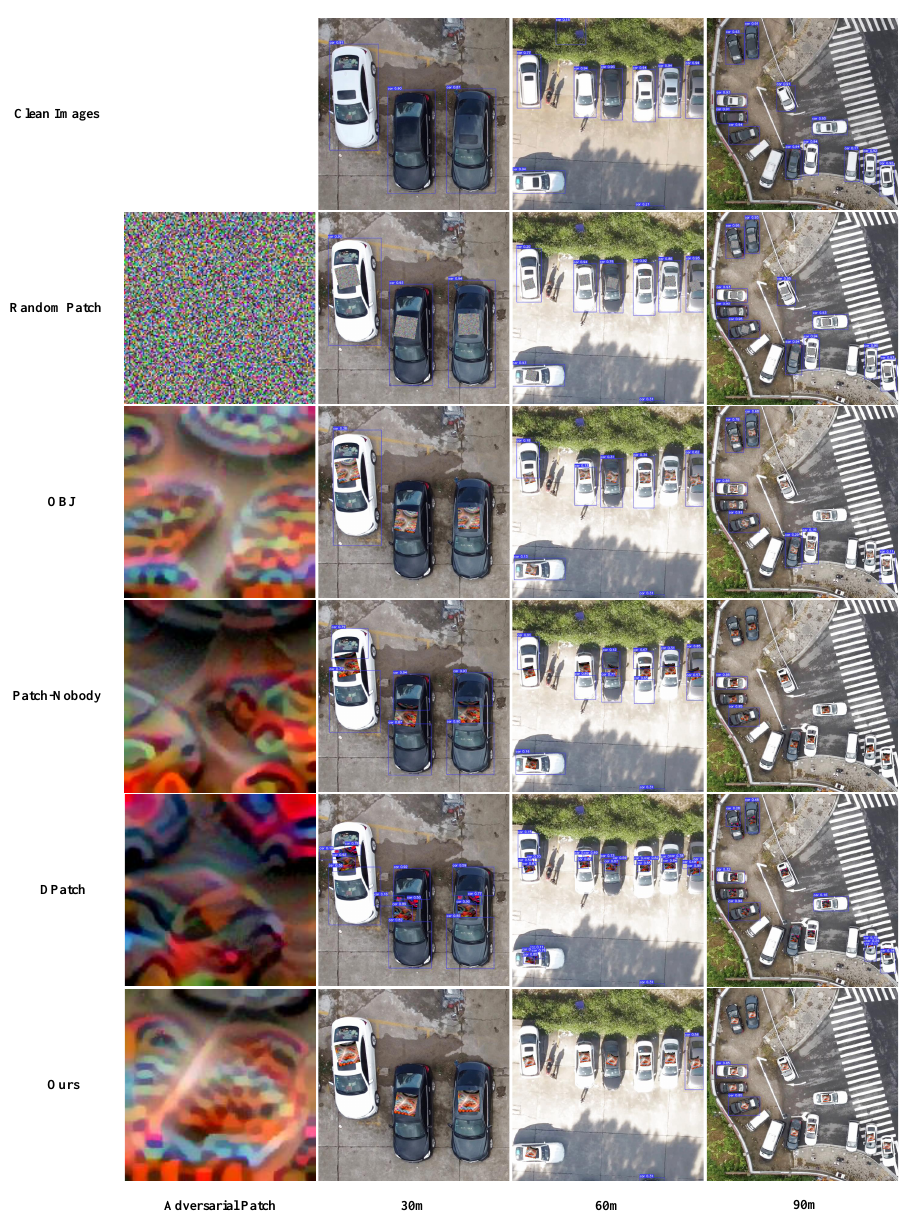
Figure 5. Comparison of the attack effects for our method, Dpatch, OBJ, Patch-Noobj and random patch for Yolo-V3. Images shown in this figure were captured at heights of 30 m, 60 m and 90